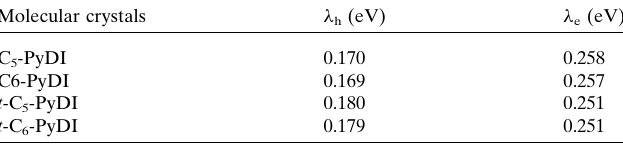
Table 1 DFT-B3LYP/6-311G** calculated hole-transfer ( (cid:4) h ) and electron- transfer ( (cid:4) e ) reorganization energies of C 5 -PyDI, C 6 -PyDI, t -C 5 -PyDI and t -C 6 -PyDI by the APS approach. Molecular